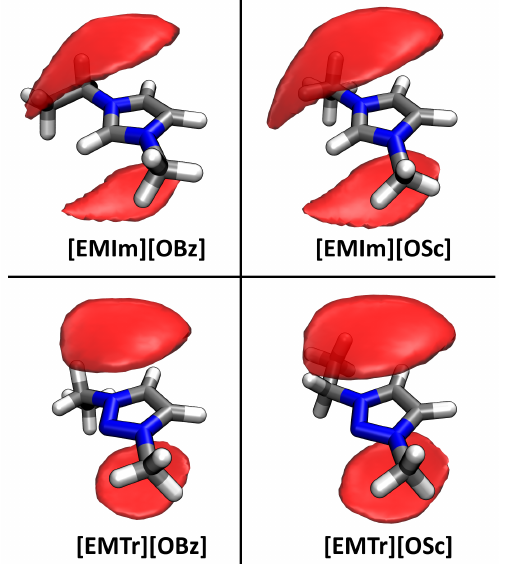
Figure 4. Spatial distribution function (SDF) of the anions’ ring centroids around the cation, shown at an isovalue of 12nm − 3 . Aromatic ring stacking between anion and cation is clearly